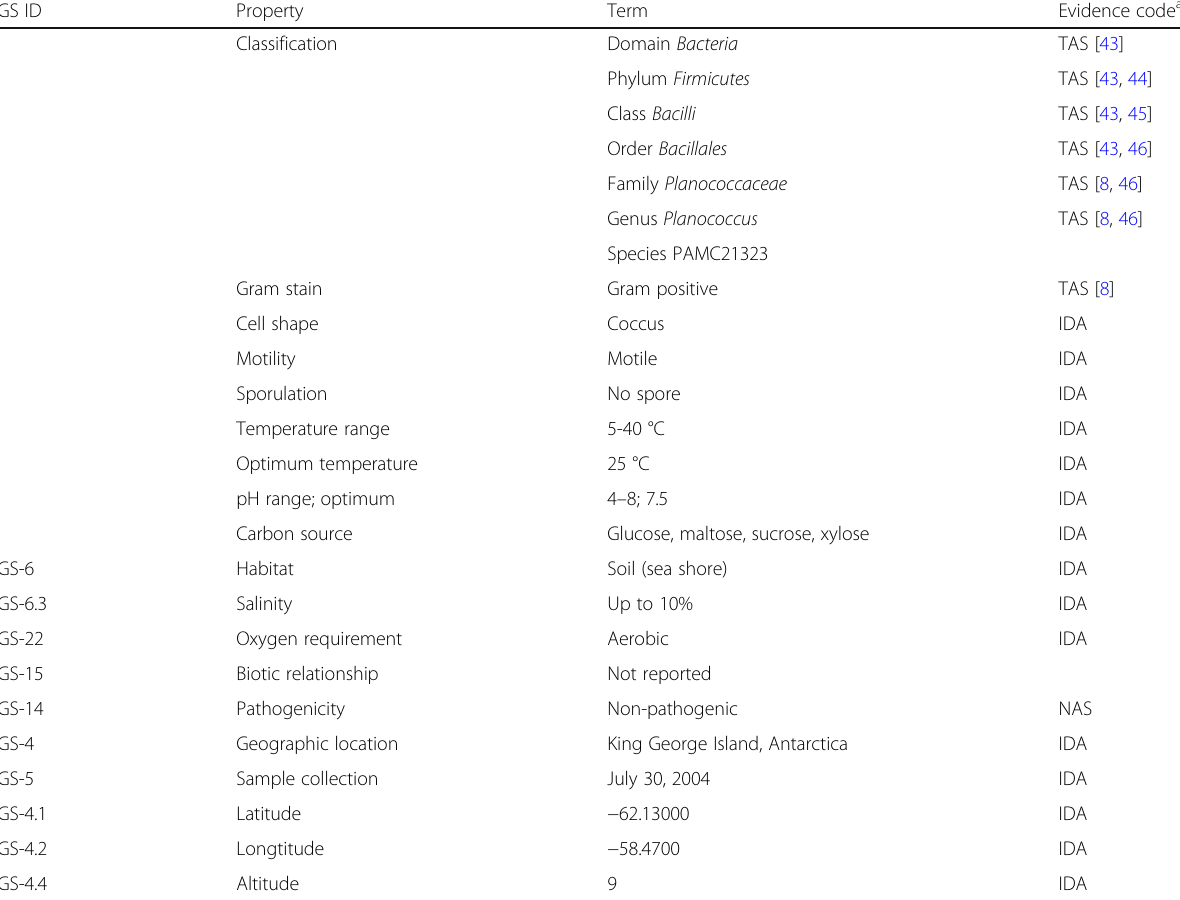
Table 1 Classification and general features of Planococcus sp. PAMC21323 according to the MIGS recommendation [42]